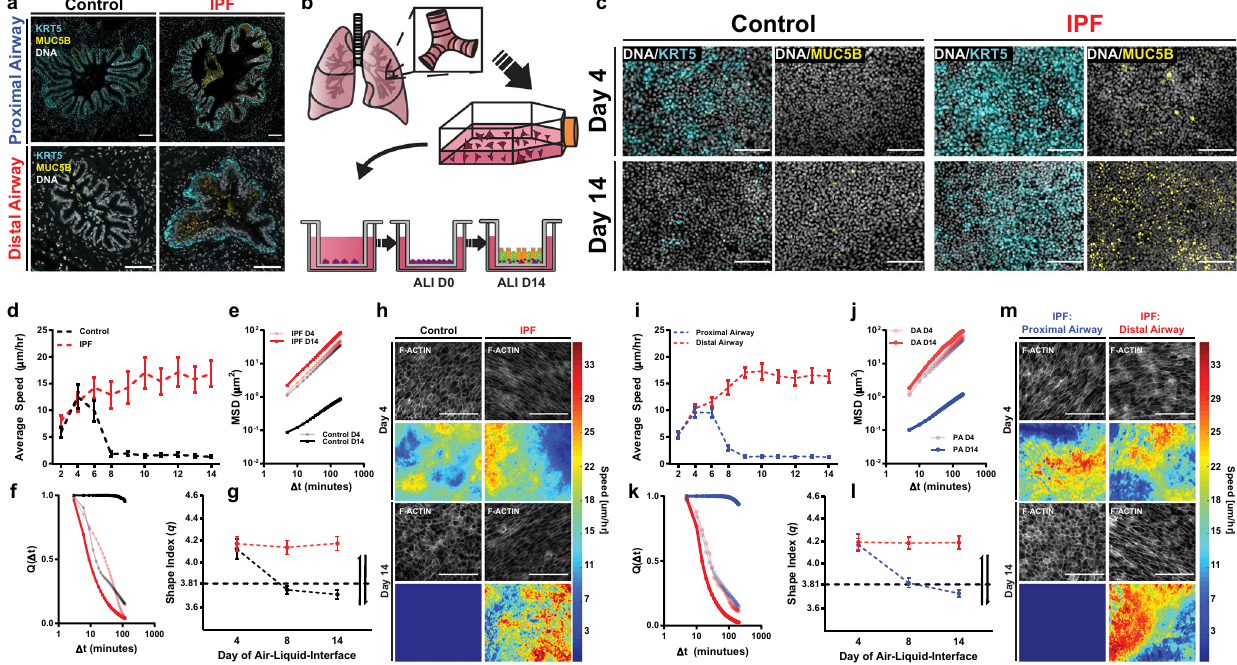
Fig. 1 The IPF distal airway is recapitulated in vitro and persists in the unjammed phase. Representative distal human airways have increased KRT5 and MUC5B protein ( a ) when compared to their proximal airway or control counterpart. Primary human bronchiolar epithelial cells were isolated